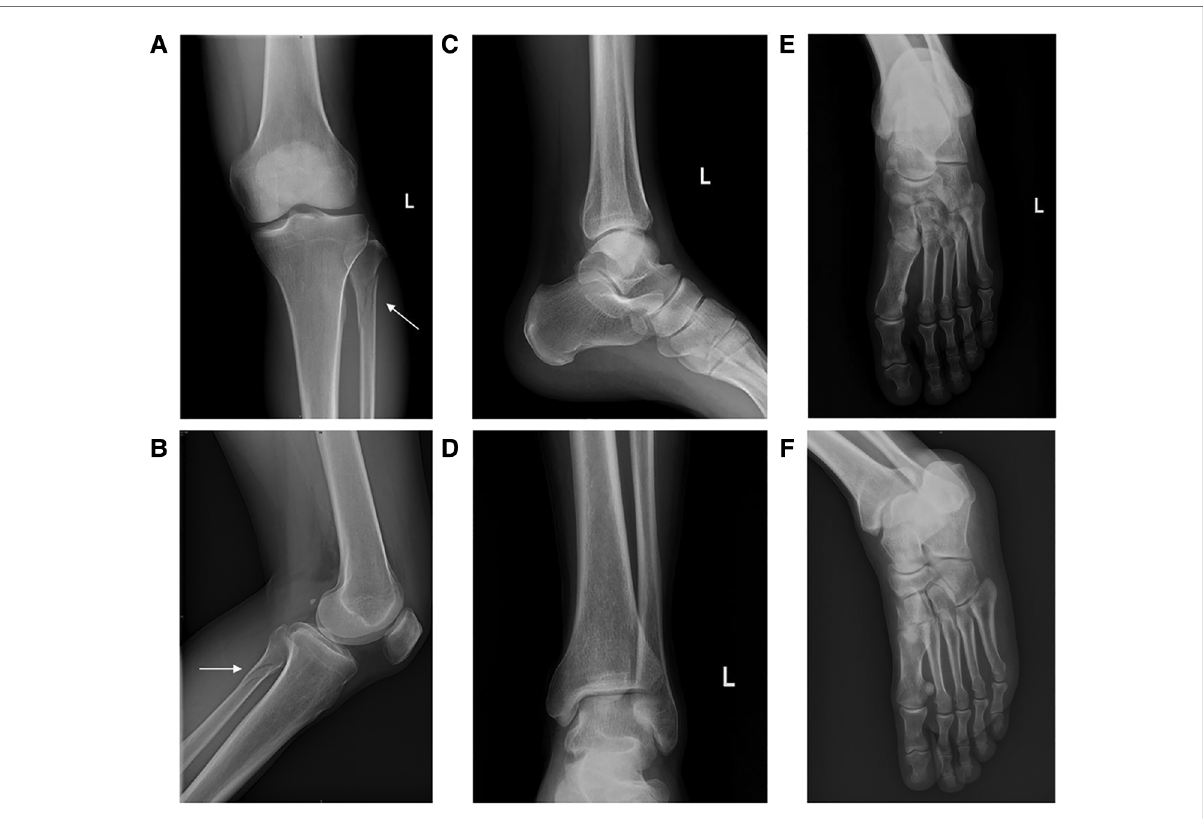
FIGURE 1 The initial x-ray images of the proximal fi bula ( A,B ), the ankle ( C,D ), and the foot ( E,F